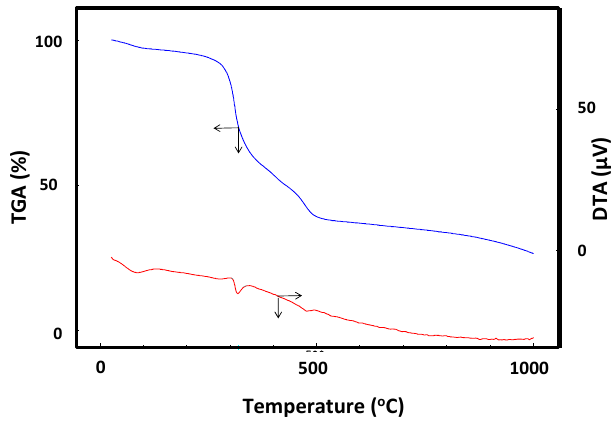
Figure 3. TGA/DTA results of amorphous N/TiO 2 .